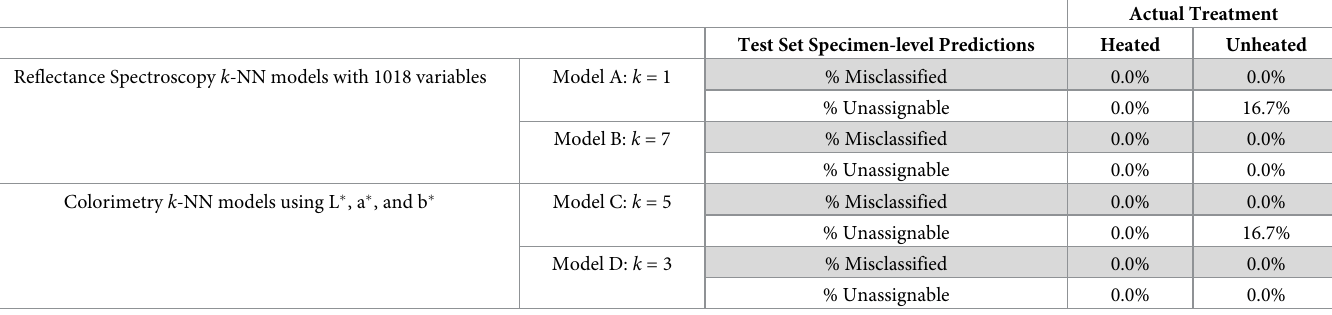
Table 14. For specimen-level predictions, the test set of all four k-NN models yielded no misclassified flakes. This suggests that our visible spectrum approach to heat treatment detection is robust and future work to develop a CIE L � a � b � -only method using less expensive and more rugged dedicated colorimeters holds